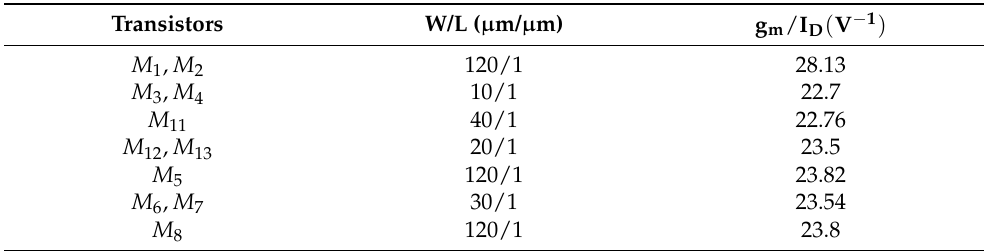
Table 1. Transistor parameters of the operational transconductance amplifier (OTA) shown in Figure